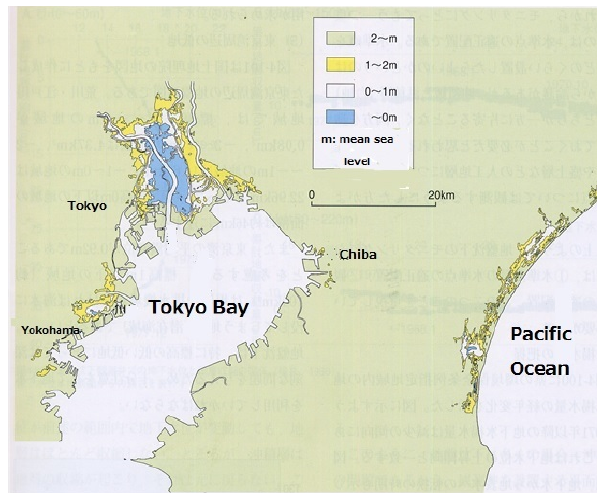
Figure 5. Lowland area around Tokyo Bay and Kujyukuri which faced the Pacific